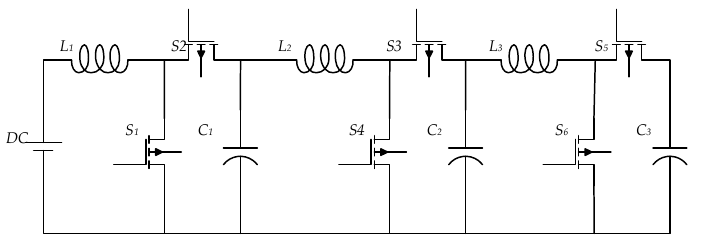
Figure 4. Connection method in D Ts and (1 − D ) Ts of three-order boost converter. ( a ) Mode Ⅰ , ( b ) Mode Ⅱ.